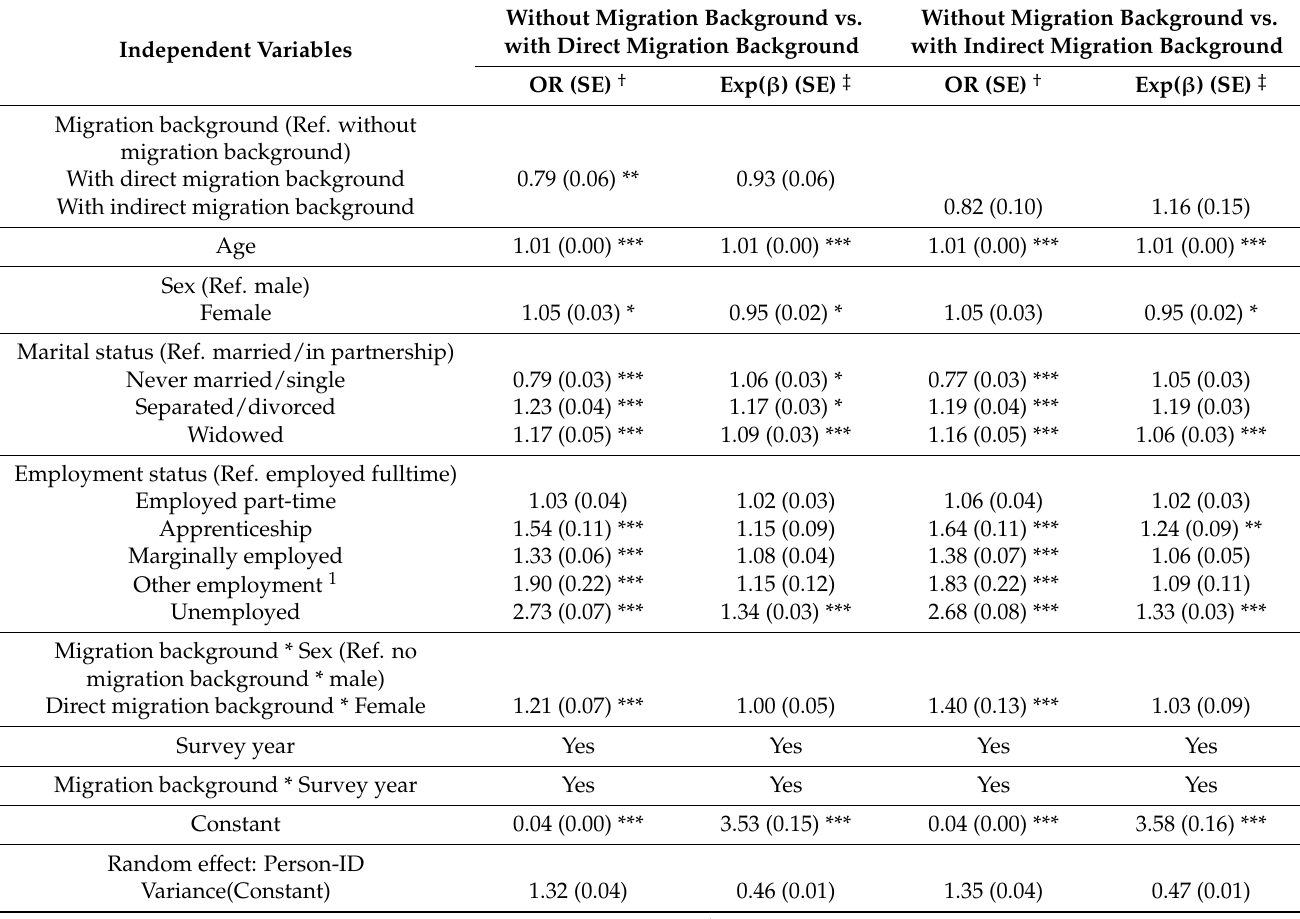
Table 3. Multilevel mixed-effects logistic regressions of hospitalization (yes/no) and zero-truncated multilevel mixed-effects generalized linear models of number of nights in hospital within the last year for persons without and with direct or indirect migration background (years 2013 to 2019, n = 43,921; 179,357 observations). Without Migration Background vs. Without Migration Background